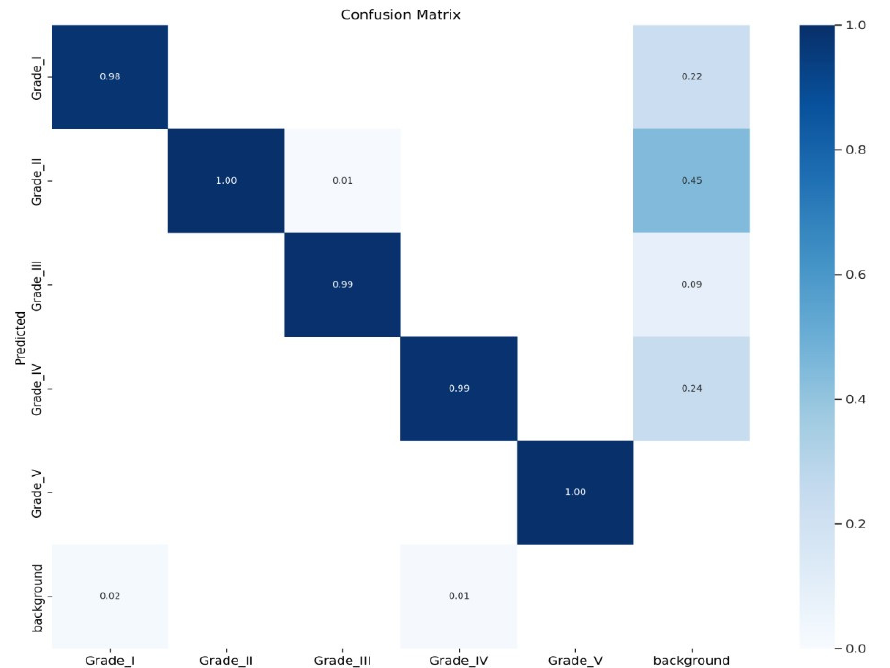
Figure 8. Confusion matrix representation and accuracy of the training model. (Grade I accuracy 0.98, grade II 1.0, grade III 0.99, grade IV 0.99, grade V 1.0). A column represents an instance of the actual class, whereas a row represents an instance of the predicted class.